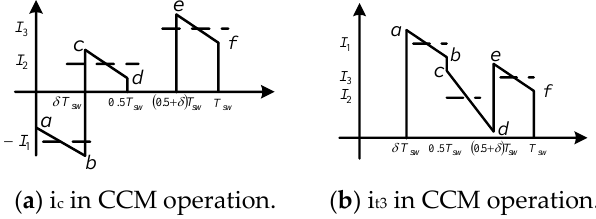
Figure 15. Capacitor and terminal three current waveforms (i c and i t3 ) .